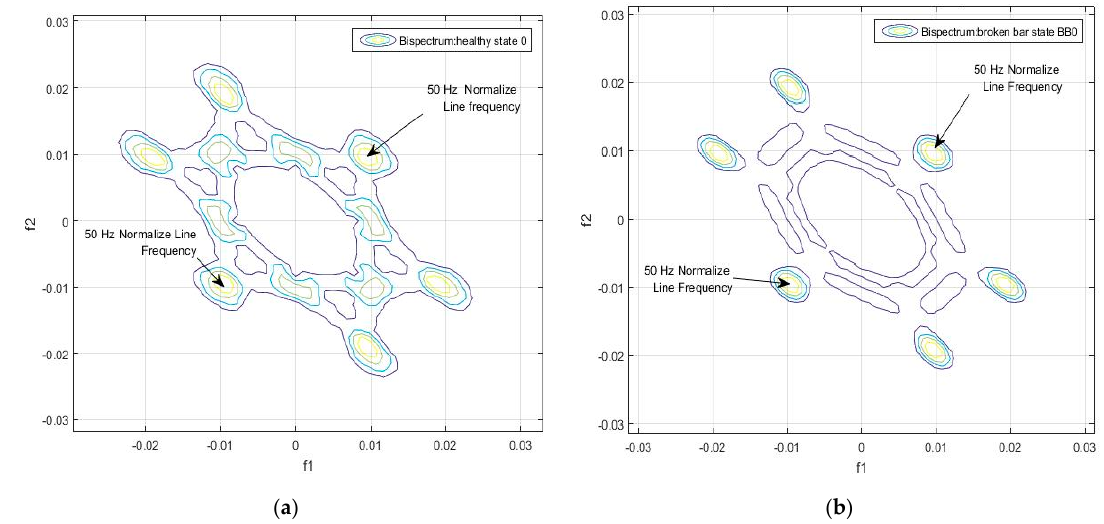
Figure 3. ( a ) Contour of bispectrum of the motor flux signal in healthy condition (sample 0, DMA position) ( b ) Contour of bispectrum of the motor flux signal in faulty condition (sample 0, DMA position).